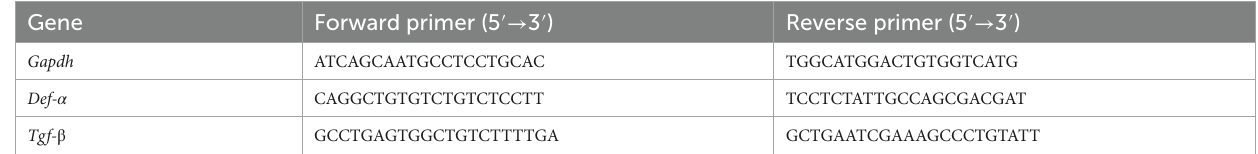
TABLE 1 List of primers used in this study.